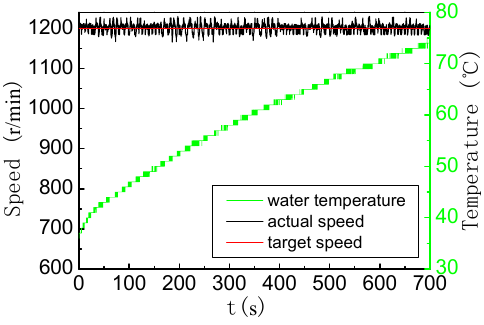
Figure 16. Water temperature rising curve.